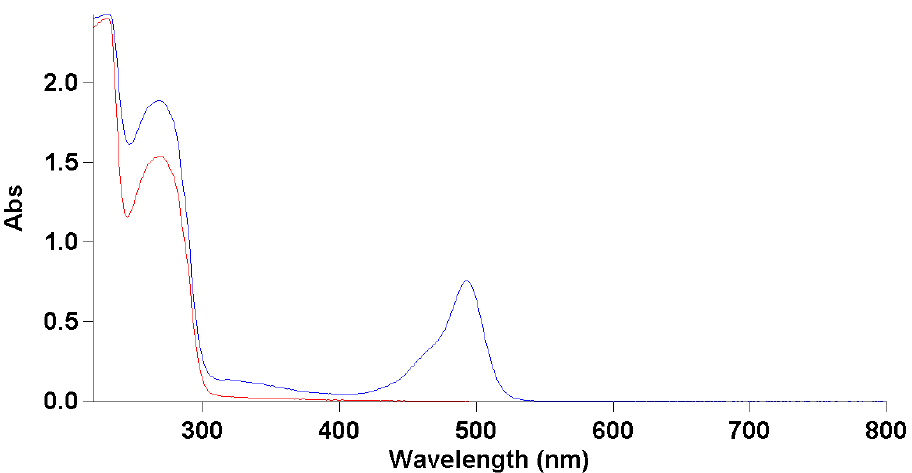
Figure 5. UV spectrum of protein fd bacteriophage before and after conjugation with FITC. The red line is the UV spectrum of bacteriophage before conjugating with FITC. The blue line is the UV spectrum of bacteriophage after conjugation with FITC.